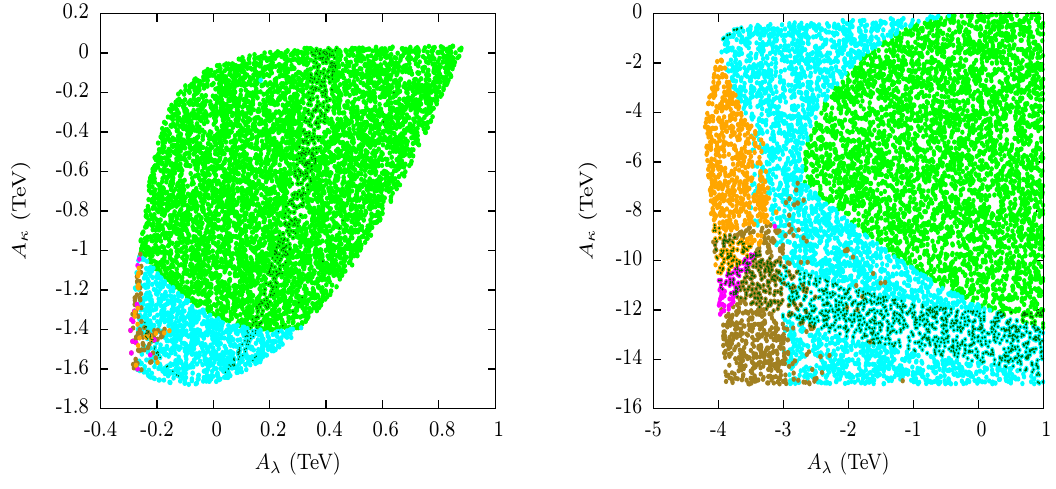
Figure 5 . Same as in (cid:12)gure 4 but for m